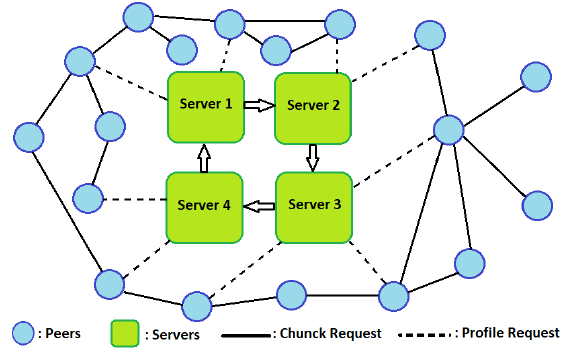
Figure 2. An overview of the P2P file-sharing